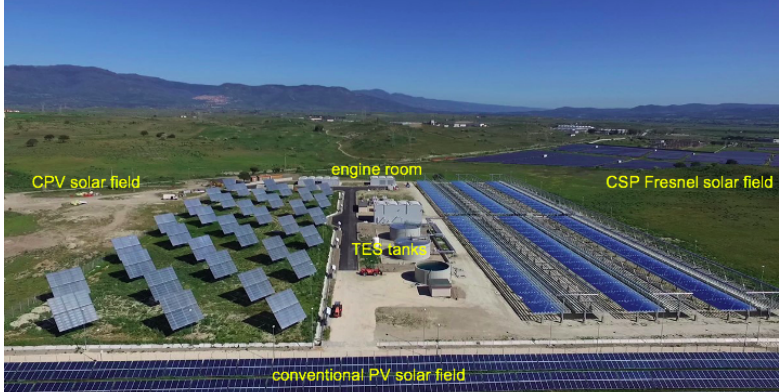
Figure 3. Overview of the Ottana solar